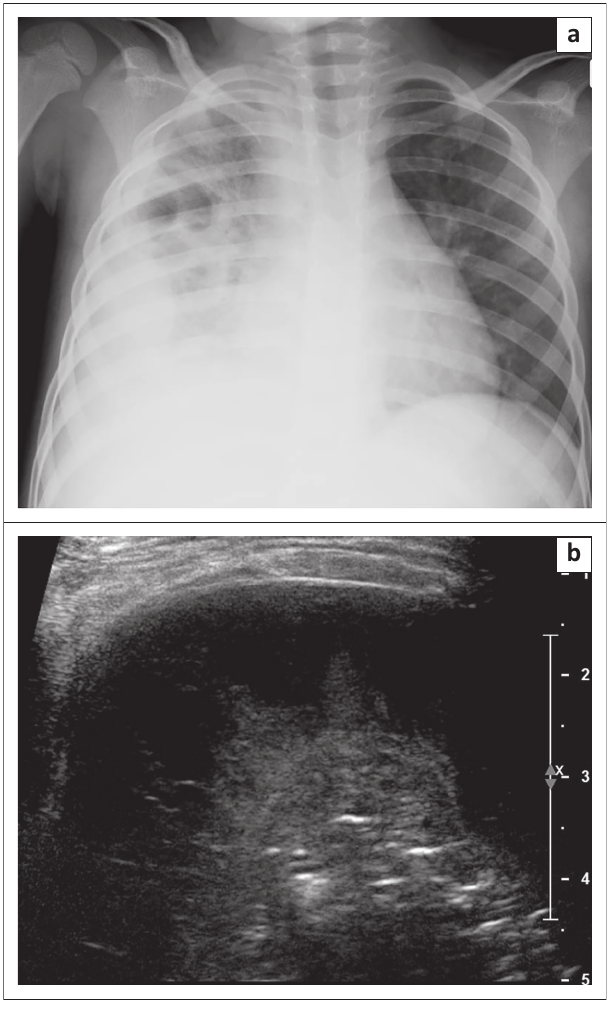
FIGURE 3: Young boy with HIV infection and S. pneumonia bacterial infection. (a) Frontal chest radiograph shows extensive consolidation and effusion in the right hemithorax. (b) Ultrasound image of the right hemithorax demonstrates underlying consolidation and complex effusion with pleural thickening suggesting empyema.